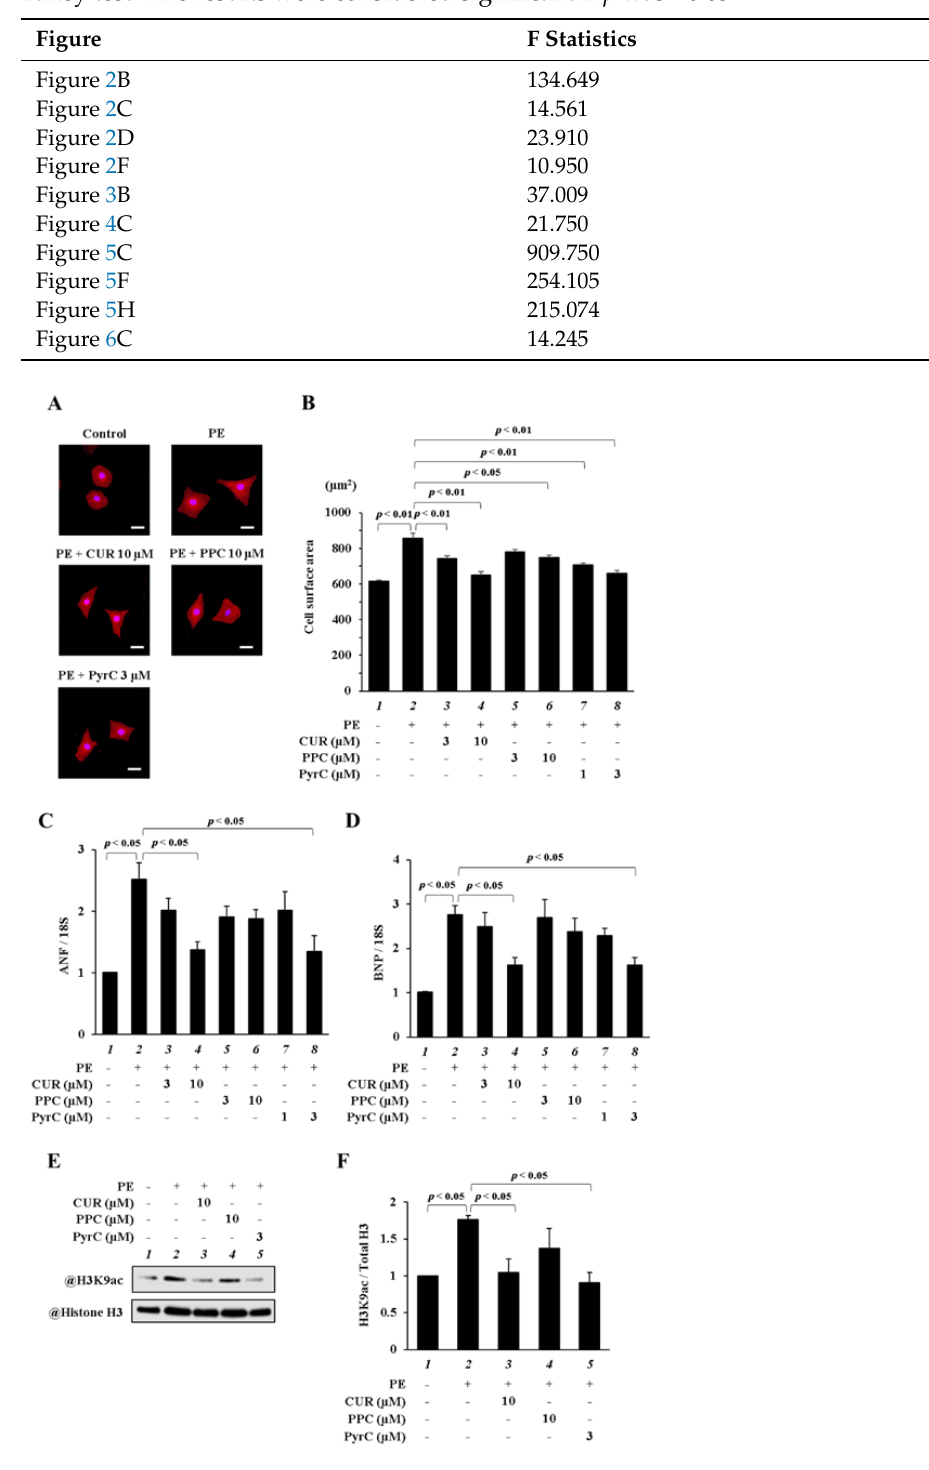
Figure 2. PyrC suppressed cardiomyocyte hypertrophy. ( A , B ) MHC immunostaining of primary cardiomyocytes. ( B ) Quantification of ( A ). Scale bar, 20 μm; N = 3. ( C , D ) mRNA levels of ANF ( C ) and BNP ( D ). N = 3. ( E , F ) Western blotting showing acetylation levels in cardiomyocytes. ( F ) Quantification of ( E ). N = 3.